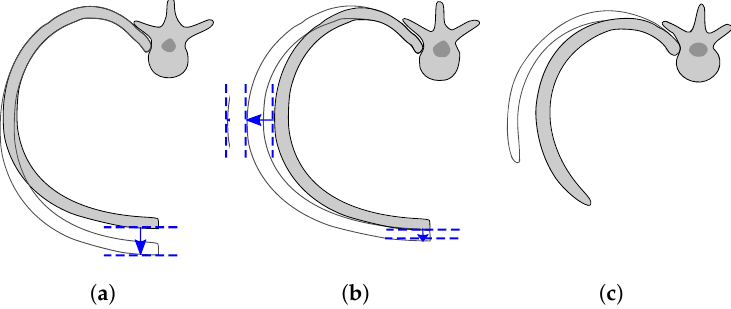
Figure 1. Chest ribs’ movements during respiration: ( a ) pump-handle motion of the upper ribs, ( b ) bucket-handle motion of the lower ribs, and ( c ) caliper motion of the lowest ribs.